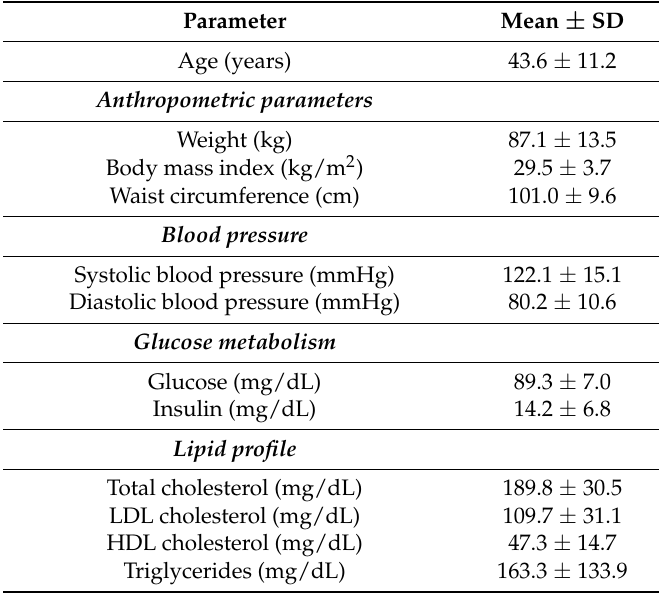
Table 2. Baseline anthropometric, clinical, and biochemical characteristics of volunteers ( n =